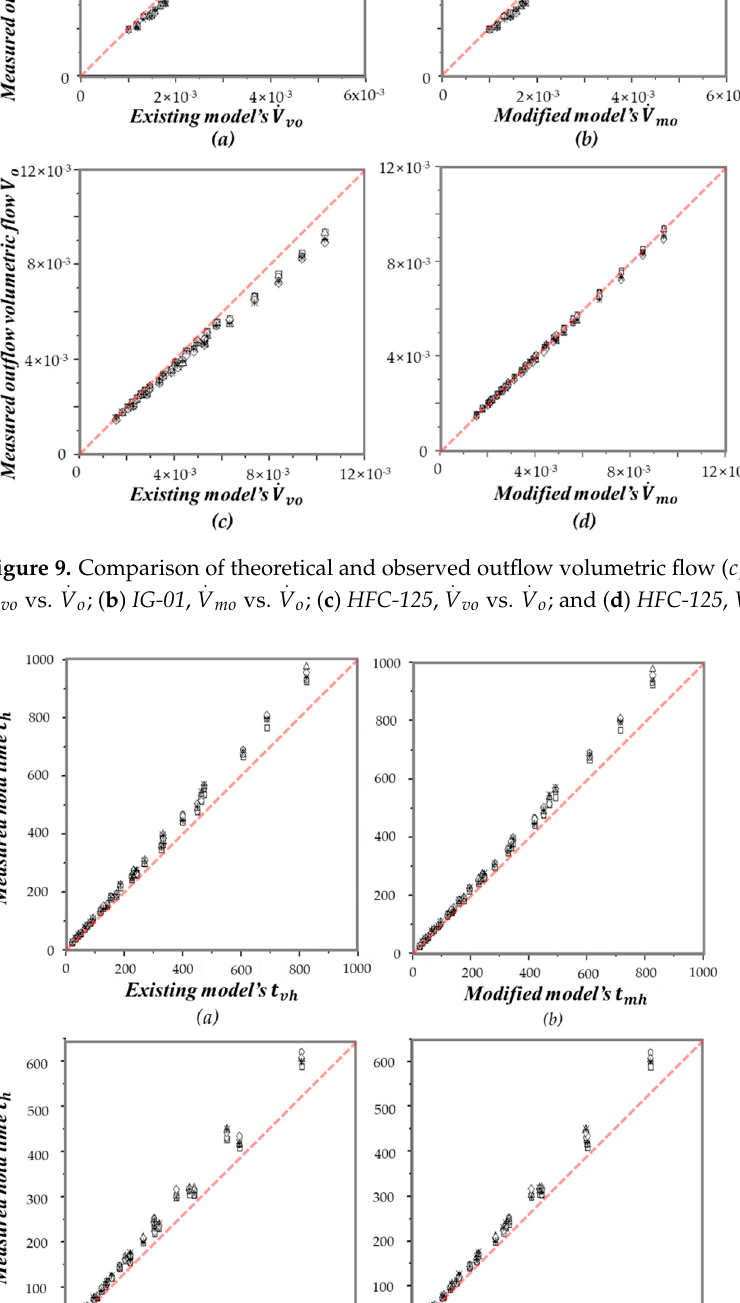
Figure 10. Comparison of theoretical and observed hold time ( c th = 0.85 c mix ) : ( a ) IG-01 , t vh vs. t h ;